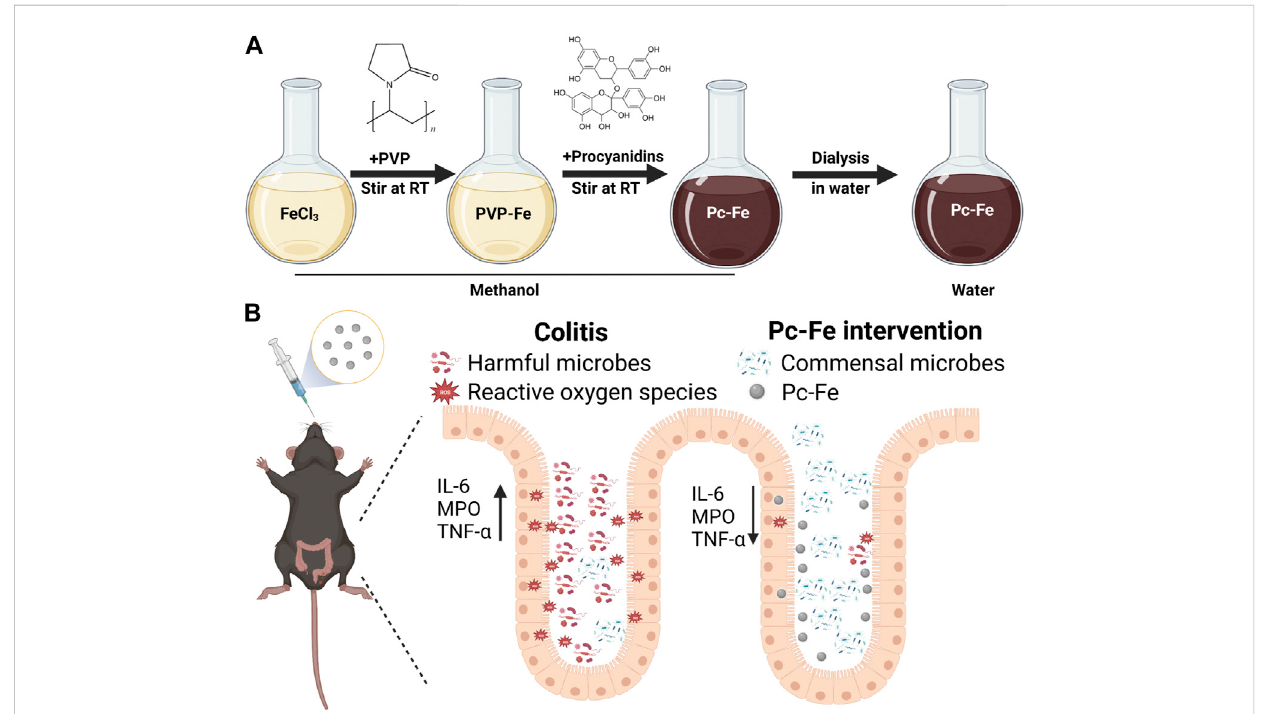
FIGURE 1 (A) The synthesis procedure of Pc-Fe and (B) schematic illustration of IBD relief with Pc-Fe. (B) During the process of acute in fl ammation (left part), thelevelsofROSincreasedandharmfulbacteriamayattachtotheinjuredintestinalepithelium,whichinhibitcommensalmicrobestocolonizeandmake function and destroy the gut barrier by up-regulating pro-in fl ammatory factors. After Pc-Fe intervention (right part), the levels of ROS decreased and probiotics Acidimicrobiia increased, which alleviated the progression of acute intestinal in fl ammation through down-regulating the pro- in fl ammatory factors, and expelling potential pathogenic